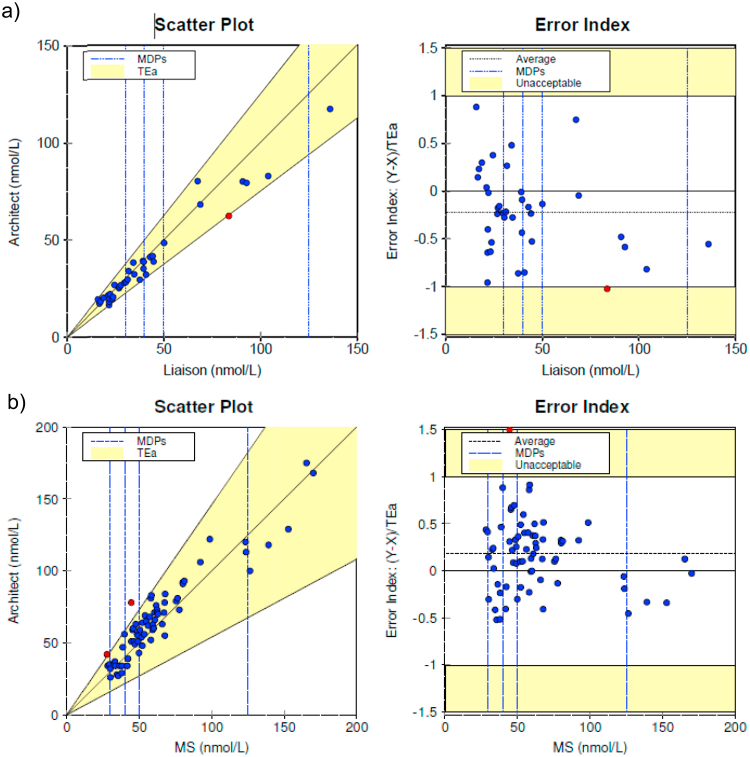
Two instrument comparisons between (a) Liaison and old Architect 25OHD (3L52) and (b) old Architect 25OHD method and LC-MS/MS (MS.) The regression line for 37 samples (a), calculated according to Deming, is indicated (25OHD old Architect nmol/L =0.85 x (25OHD Liaison) nmol/L+3.11nmol/L, r2=0.98). The regression line for 69 samples (b), calculated according to Deming, is indicated (25OHD old Architect nmol/L =0.96 x (25OHD MS) nmol/L+6.73 nmol/L, r2=0.94). The difference between the methods was within total allowable error (TEa) of 46%. The instruments produced clinically equivalent results. Results covered the medical decision points (MDPs) of 30, 40, 50 and 125 nmol/L.